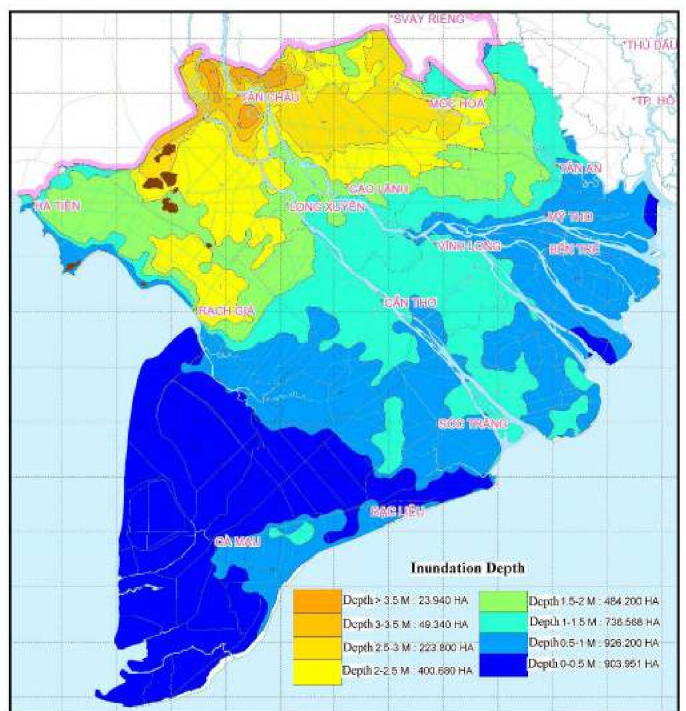
Figure 3. Inundation map of the Mekong Delta in 2000 floods. Orange and yellow colored areas (An Giang and Dong Thap province) often su ff er heavy floods in the rainy season (inundation in 2000 was serious, and water depth was 2.0–3.5 m). Source: Southern Institute for Water Resources Planning (SIWRP) [22].